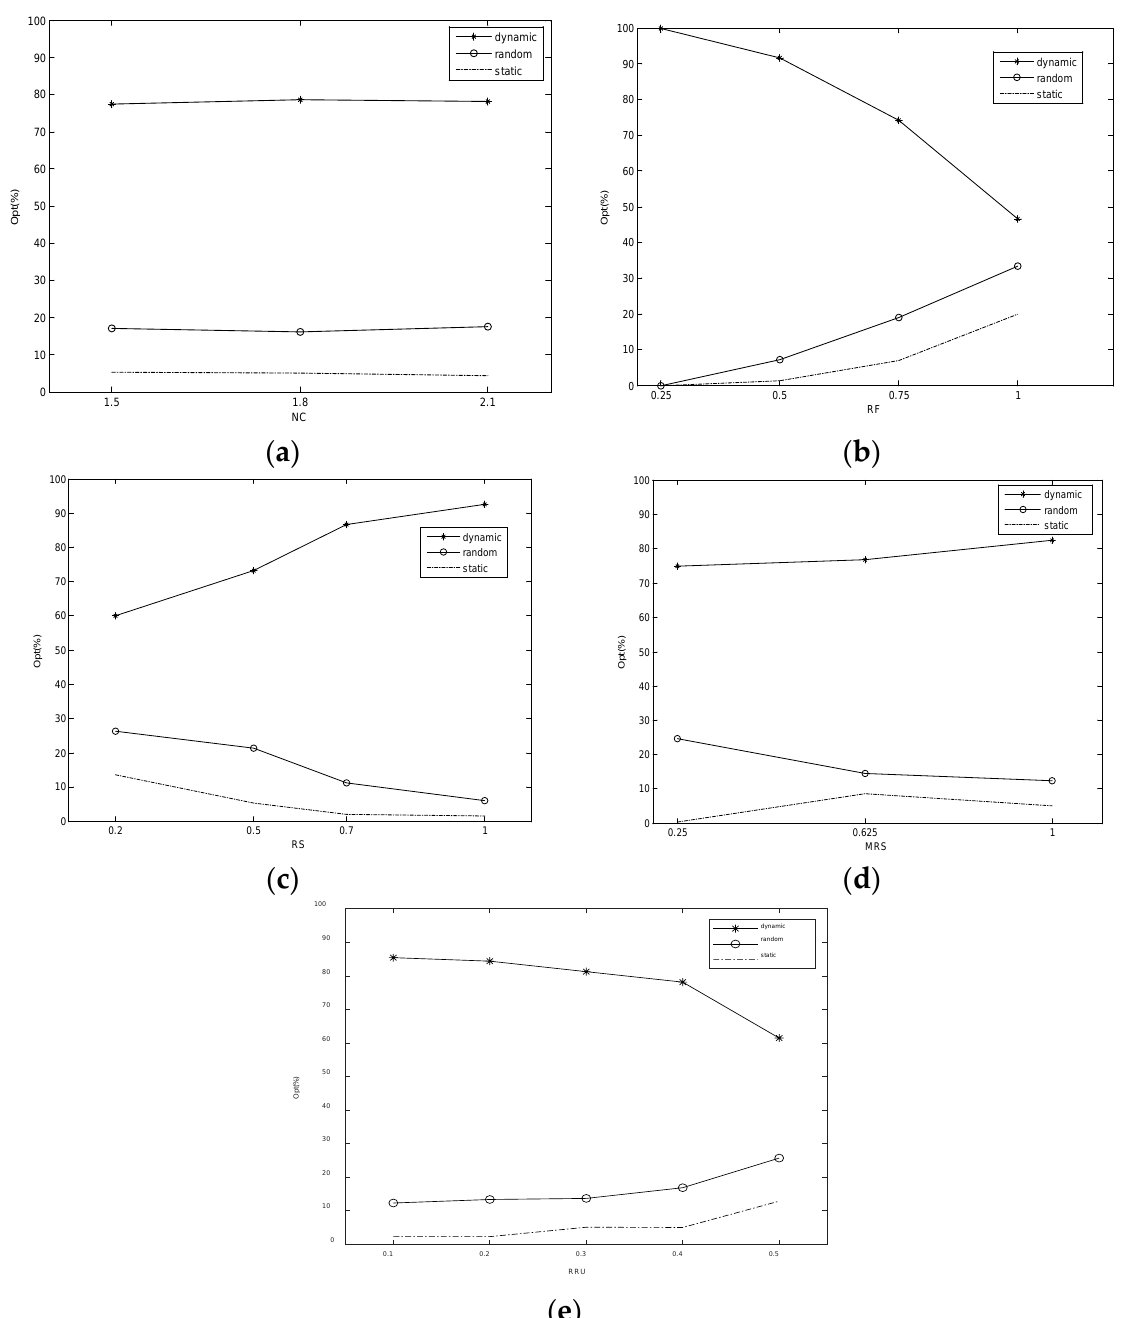
Figure 6. ( a ) Comparison results of NC . ( b ) Comparison results of RF. ( c ) Comparison results of RS . ( d ) Comparison results of MRS . ( e ) Comparison results of RRU.